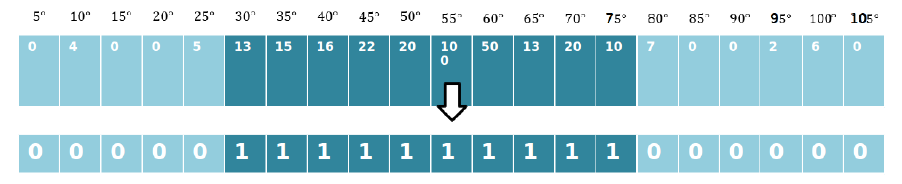
Figure 6. User Indoor Spatial Information.